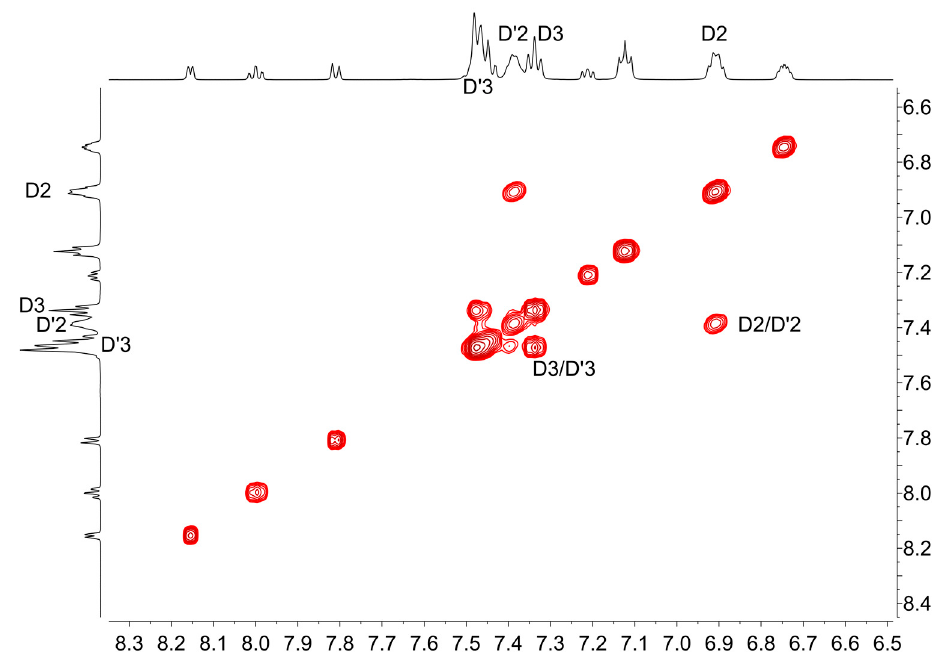
Figure 5. EXSY peaks in the ROESY spectrum of [Cu(POP)( t BuSPy)][PF 6 ] (500 MHz, acetone- d 6 , 238